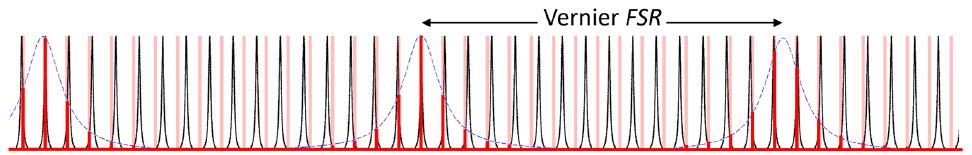
Figure 2. Continuous filtering of a comb by a cavity with L PM / Δ L = 17 (note that typically this ratio is of the order of a few thousand). Several neighboring comb modes (red solid bars) are partially transmitted through their corresponding cavity resonances (black solid curves), creating Vernier orders with envelopes shown by the blue dashed curve.